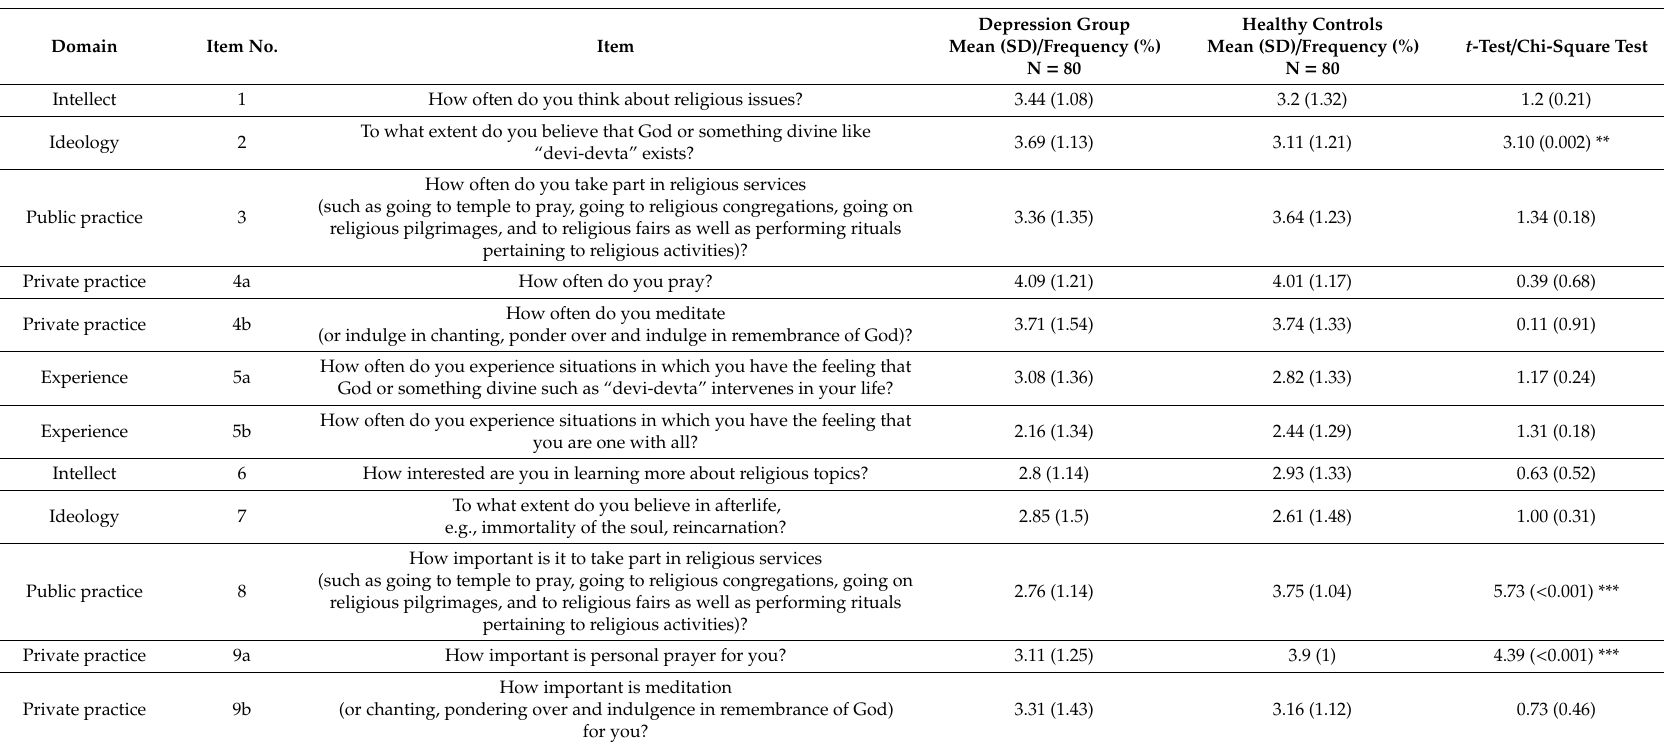
Table 2. Comparison of religiosity of healthy subjects and those with